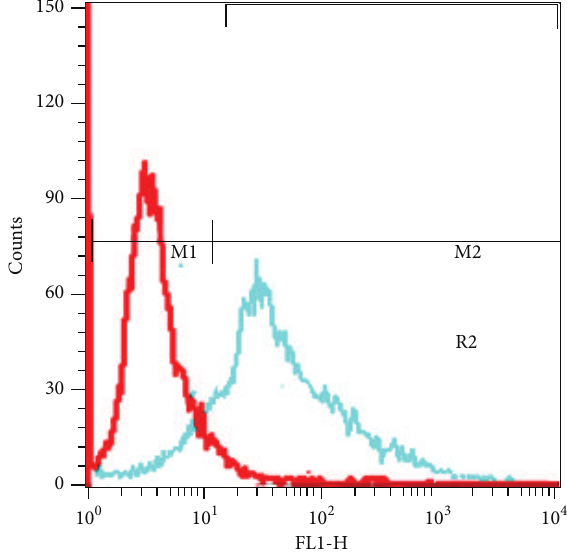
Figure 5: Graphs of flow cytometry for OVCAR3 cell